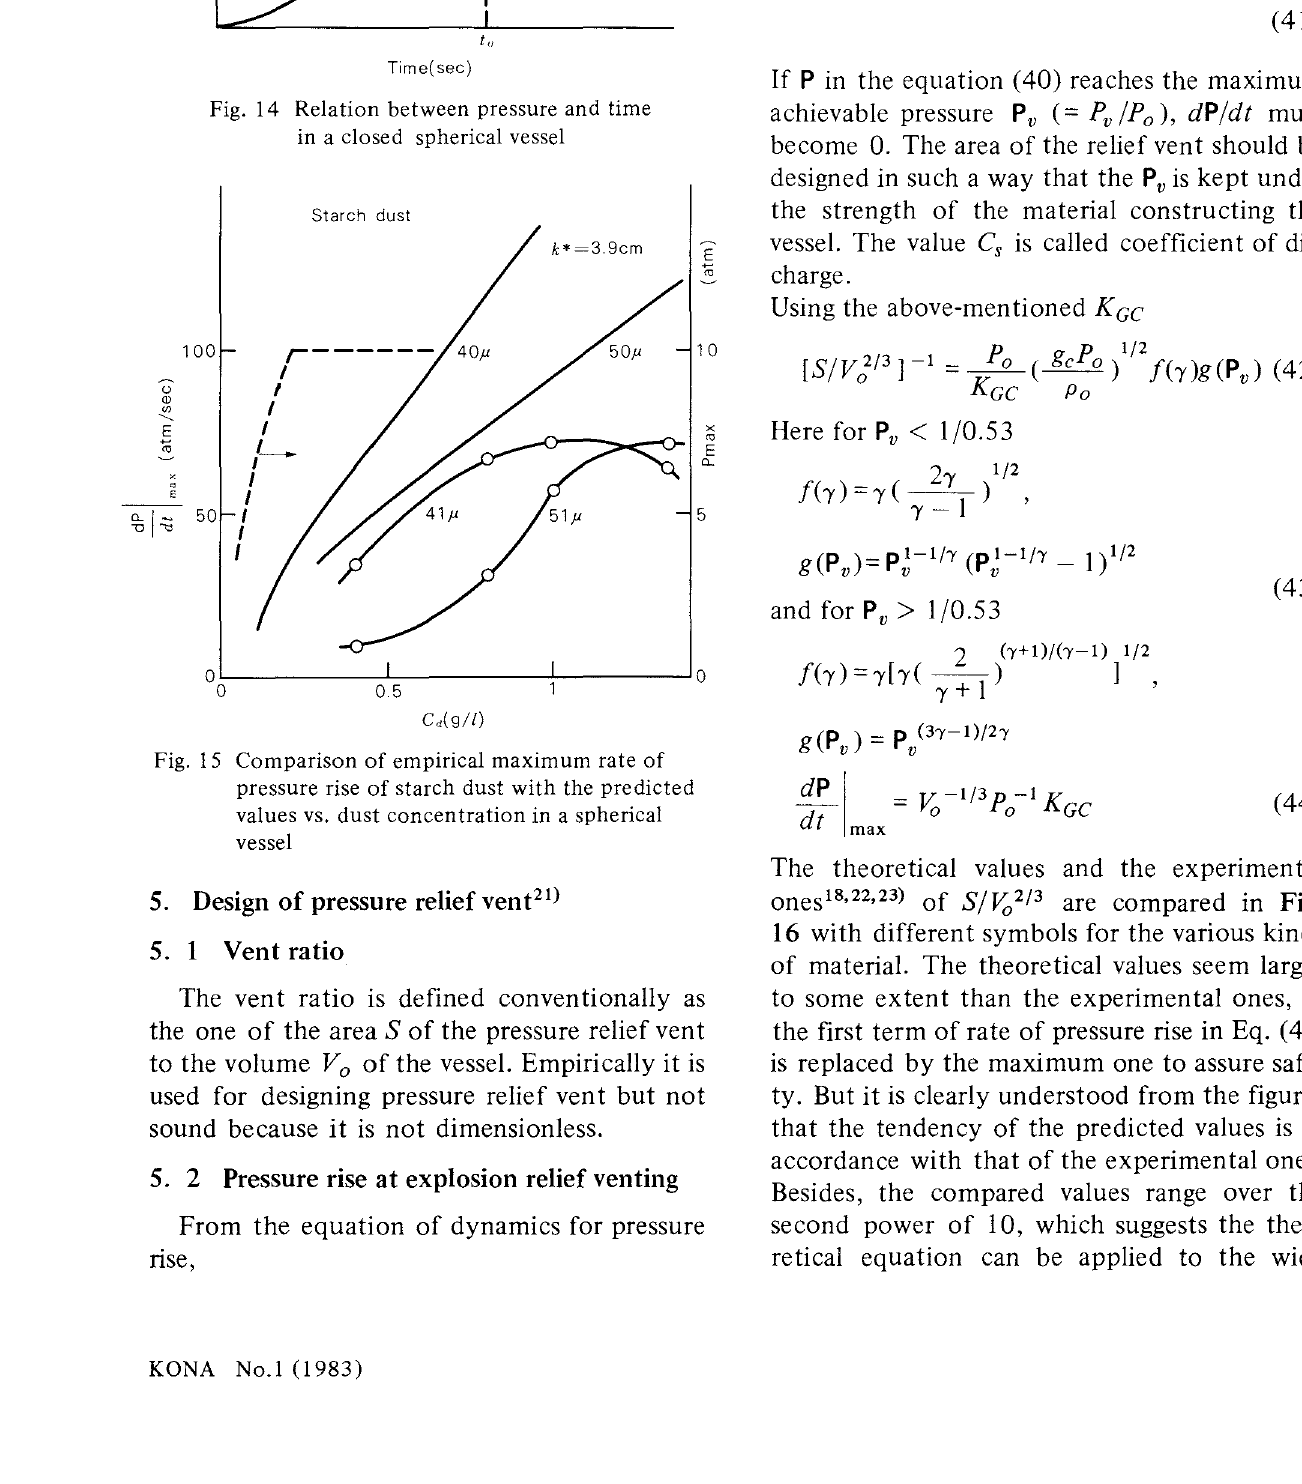
Fig. 14 Relation between pressure and time in a closed spherical vessel